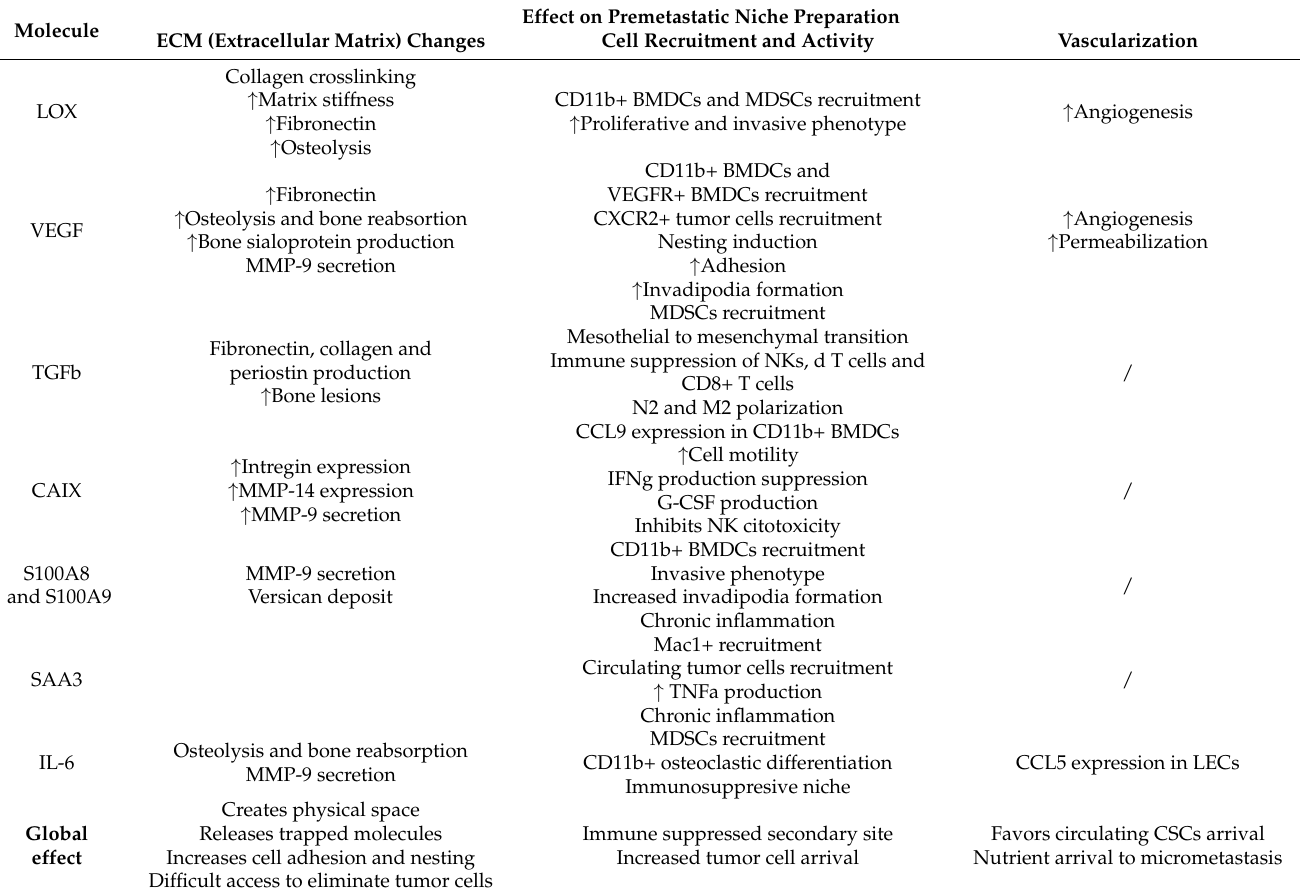
Table 1. Summary of the role of several hypoxia-induced molecules in the generation of the premetastatic